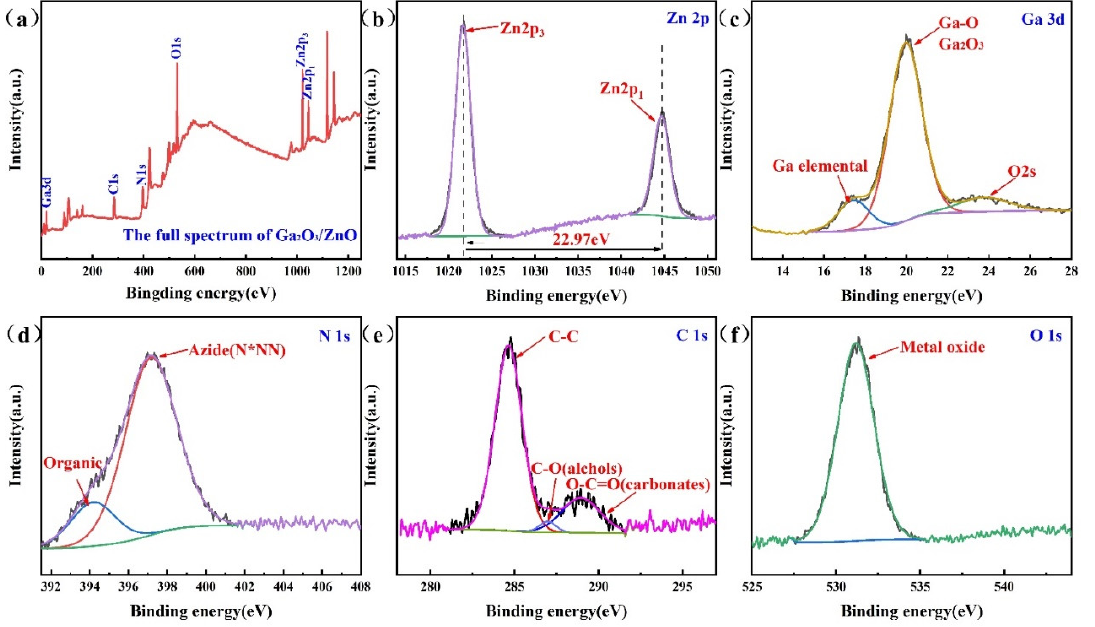
Figure 5. The XPS general spectra of ( a ) Ga 2 O 3 /ZnO, ( b ) the magnified Zn, ( c ) Ga, ( d ) N, ( e ) C, and ( f ) O spectra.